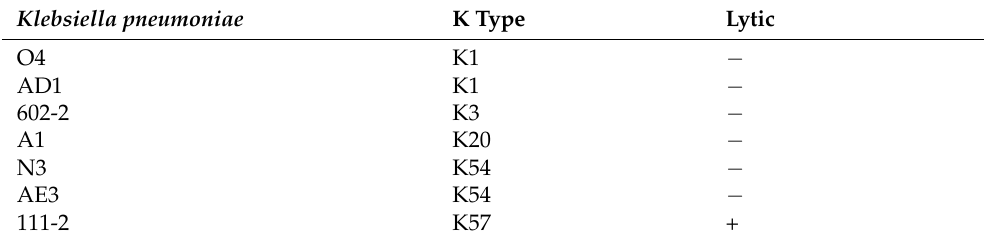
Figure 1. Phage morphology: ( a ) plaque and ( b ) transmission electron microscope of phage vB_KpnP_ZX1. Table 1. Host range of phage vB_KpnP_ZX1.